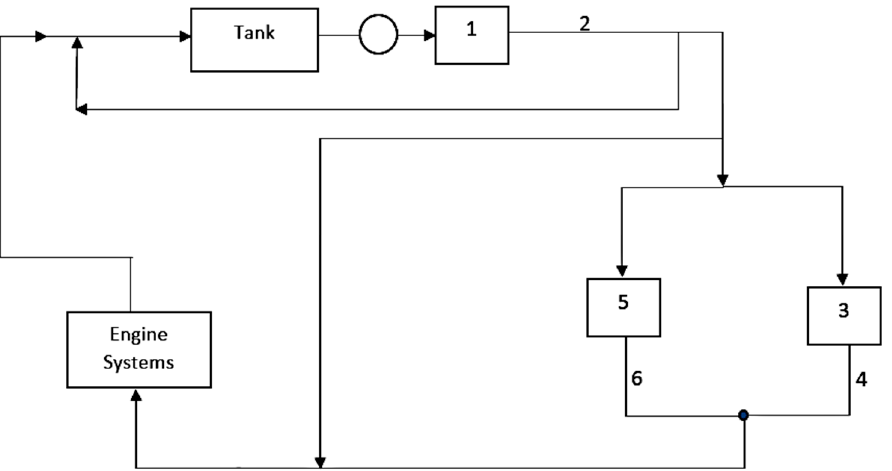
Figure 3. Thermal management system embodiments with different temperature loops proposed by United Technologies Corporation.